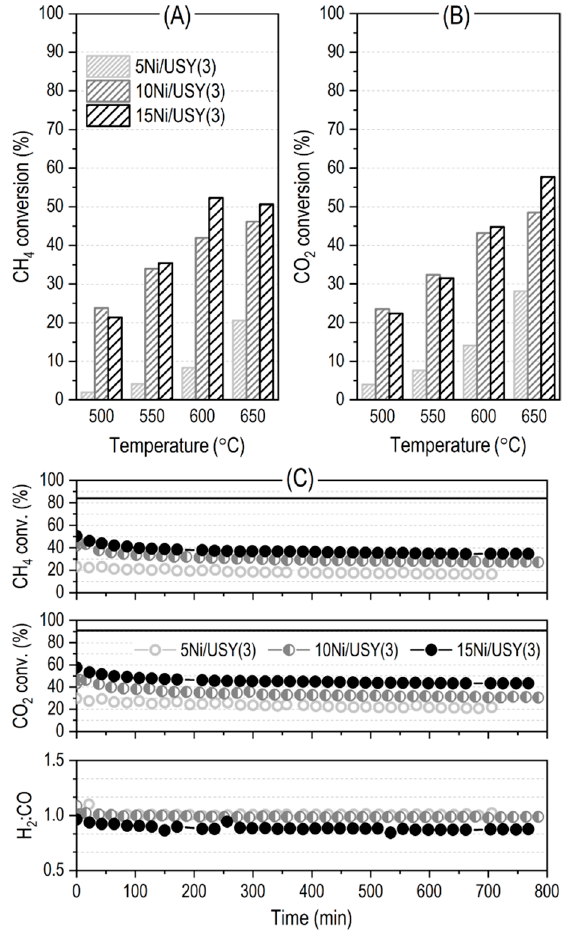
Figure 6. Variation of ( A ) CH 4 and ( B ) CO 2 conversion levels as a function of temperature (500–650 °C) and ( C ) CH 4 conversion, CO 2 conversion and H 2 :CO molar ratio as a function of time on stream (T= 650 °C) during DRM (P = 1 atm, CH 4 :CO 2 = 1:1, GHSV = 72 L g − 1 h − 1 ) over 5Ni/USY(3), 10Ni/USY(3) and 15Ni/USY(3) catalysts. Thermodynamic values of CH 4 , CO 2 , and H 2 :CO (straight black line) in ( C ) were calculated using the HSC 7.1 software.